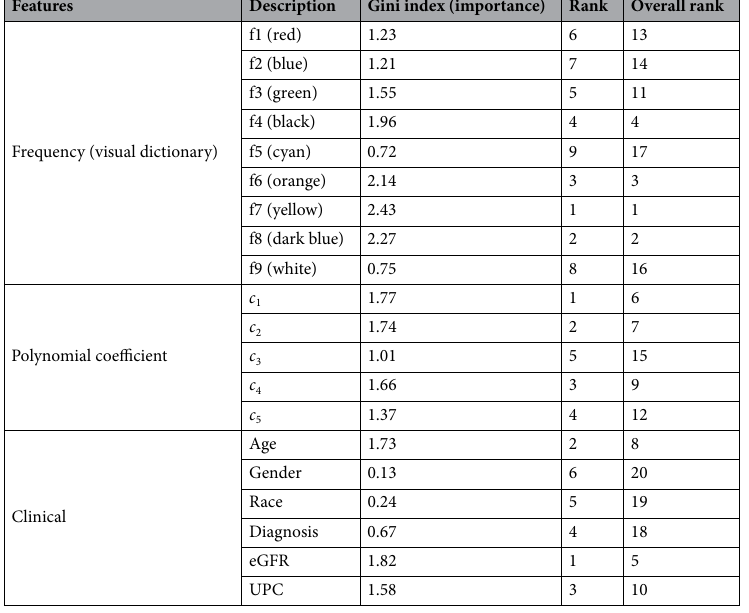
Table 4. Ranking of the important features for the prediction of eGFR slope. c n , polynomial coefficients in Eq. (1); UPC, urine protein creatinine